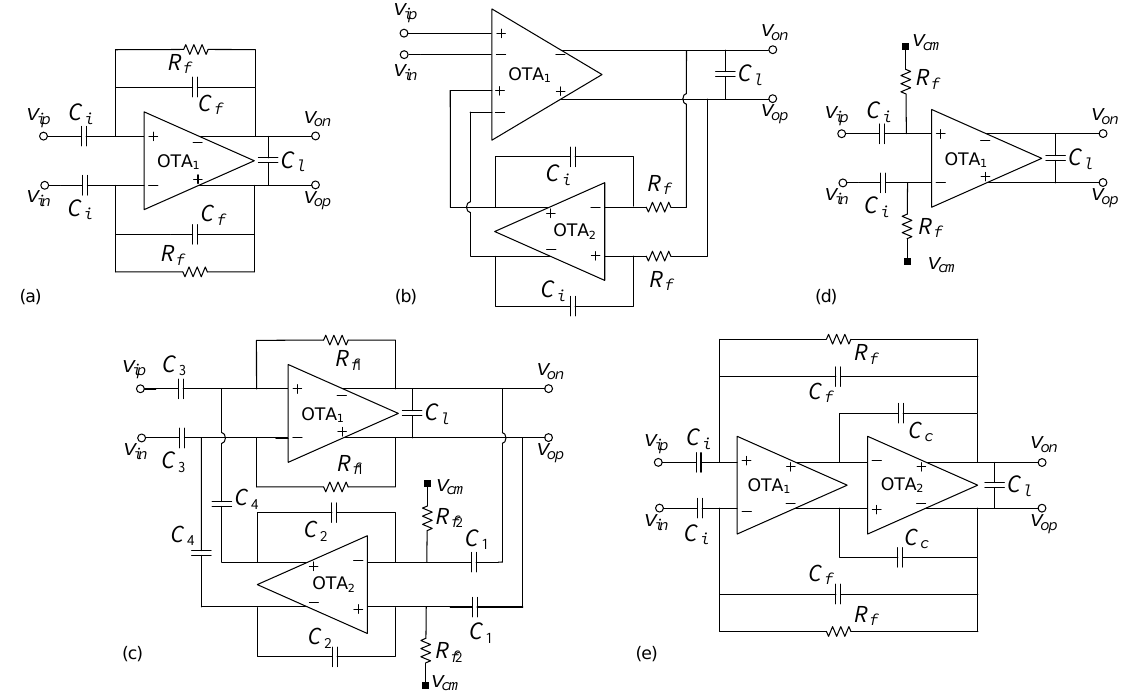
Figure 2. LNA architectures reviewed: ( a ) CFN; ( b ) MIFN; ( c ) CAFN; ( d ) OLN; and ( e ) MCCFN